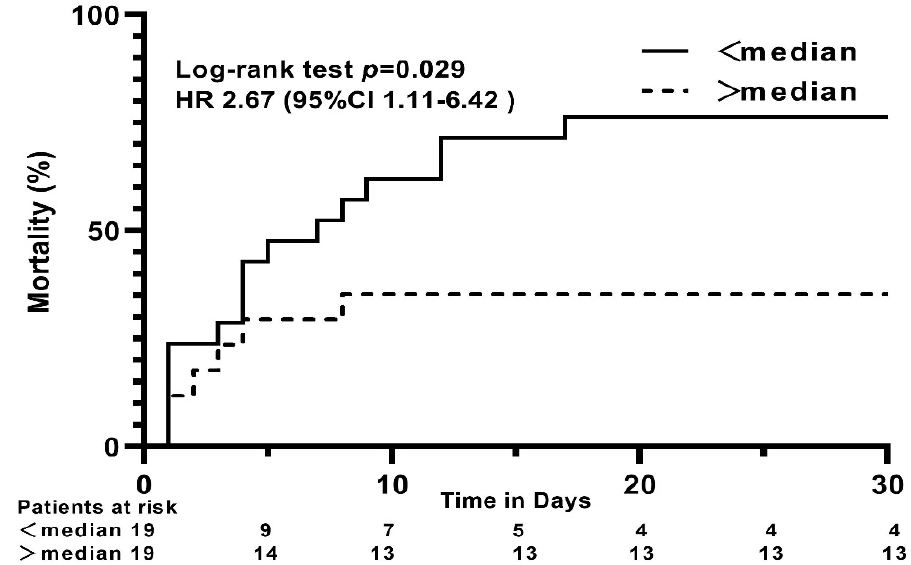
Figure 3. Kaplan–Meier analysis for all-cause mortality at 30 days in cardiogenic shock complicating acute myocardial infarction patients with Galectin-3 levels <median (black solid line) and >median (black dashed line) on day 1.